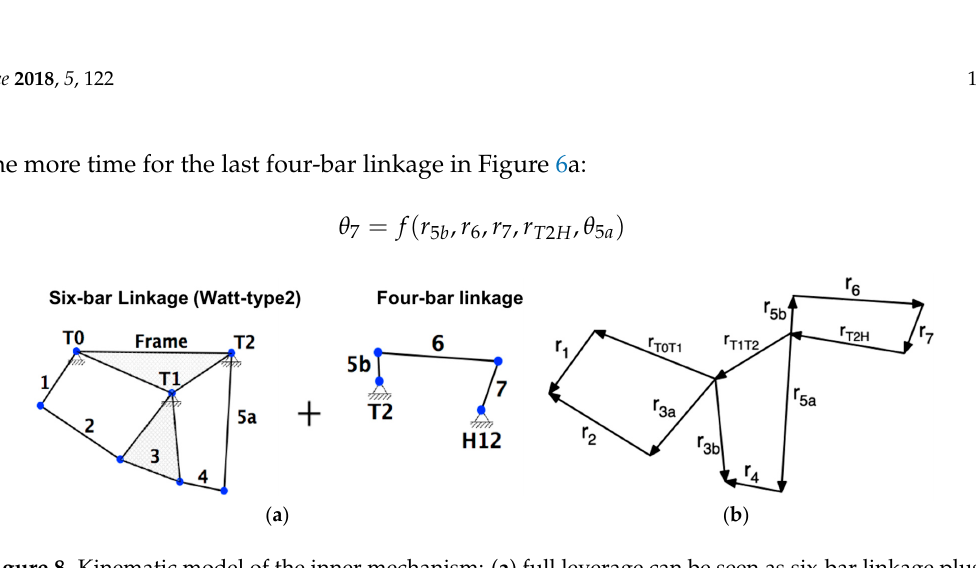
Figure 8. Kinematic model of the inner mechanism: ( a ) full leverage can be seen as six-bar linkage plus a four-bar linkage; ( b ) Vector loop equations.